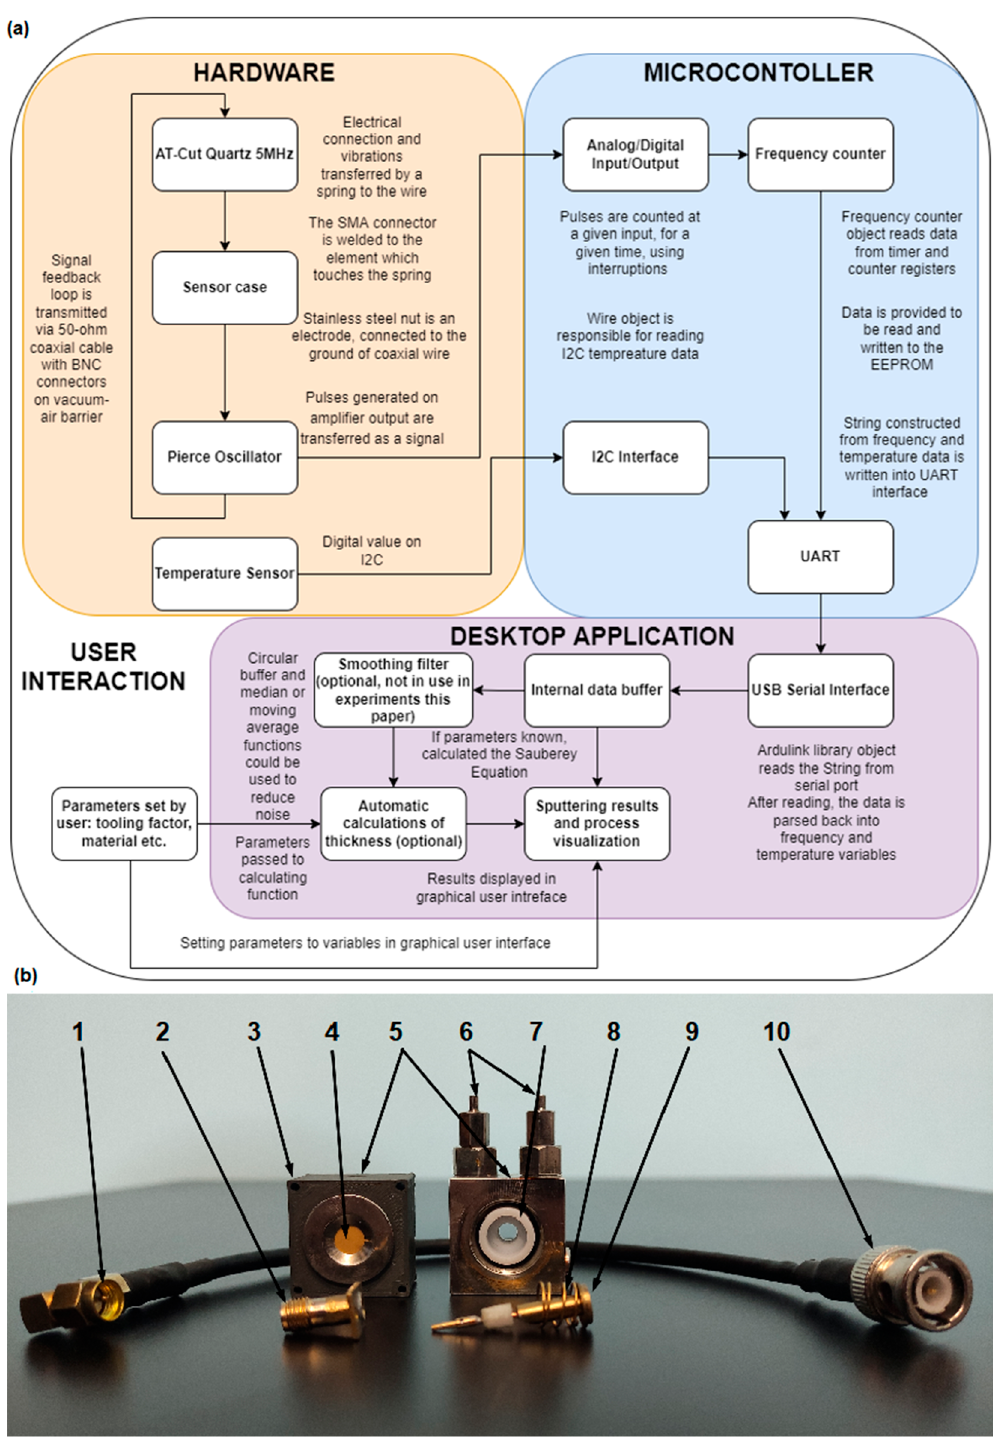
Figure 1. The described QCM system ( a ) hardware and logic block within the device, ( b ) physical elements of the system: 1 — SMA angle plug, 2 — SMA female connector with a soldered plate for fixing the connector to the case, 3 — additional holes in 3D printed case for electrostatics protection, 4 — quartz crystal fit inside the original metal nut, 5 — hole for bayonet fitting, 6 — a cooling system in an original metal case, 7 — Polytetrafluoroethylene (PTFE) sleeve (in the 3D version it is a part of a model), 8 — spring, 9 — disk-shaped ended brass sleeve, 10 — BNC connector to vacuum gland.